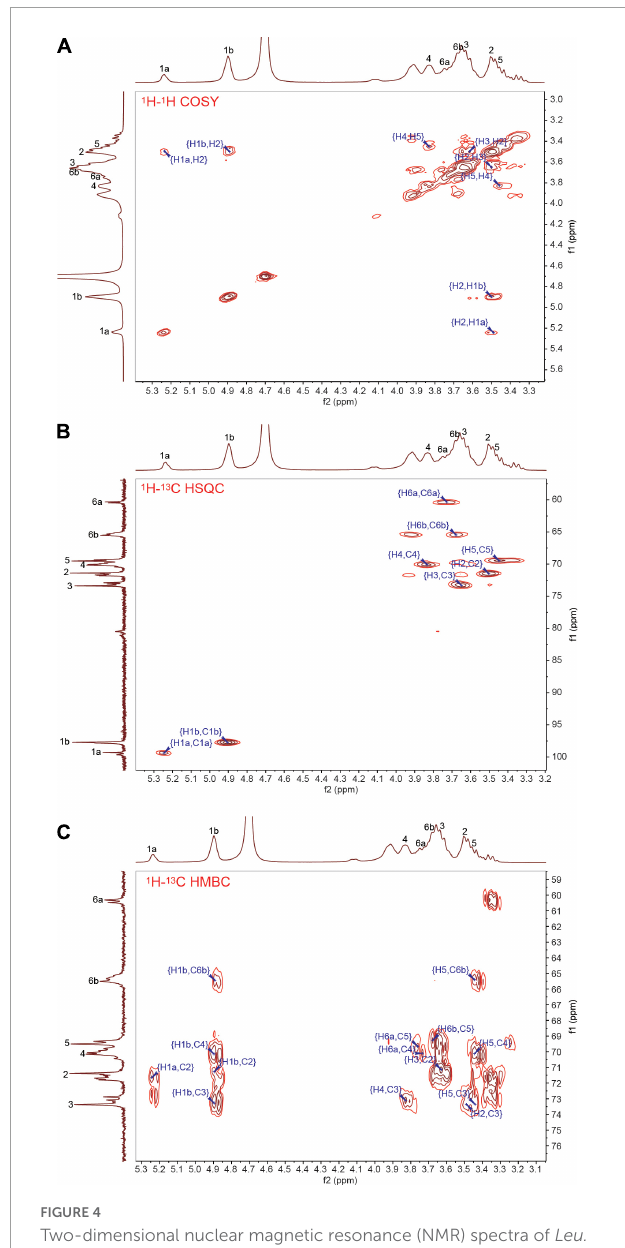
FIGURE4 Two-dimensional nuclear magnetic resonance (NMR) spectra of